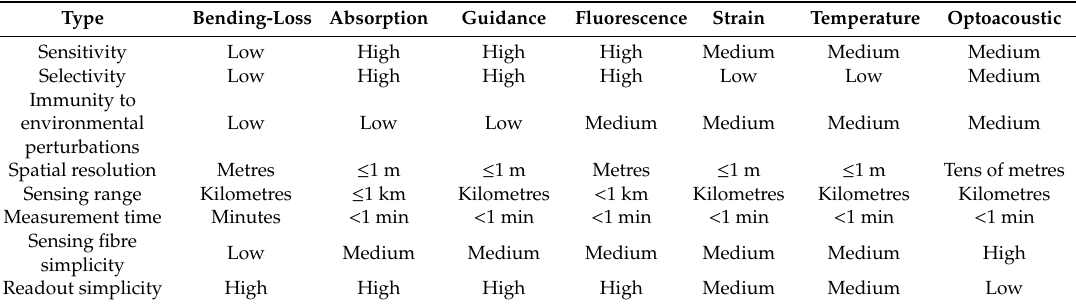
Table 1. Performance evaluation for di ff erent distributed chemical sensors.